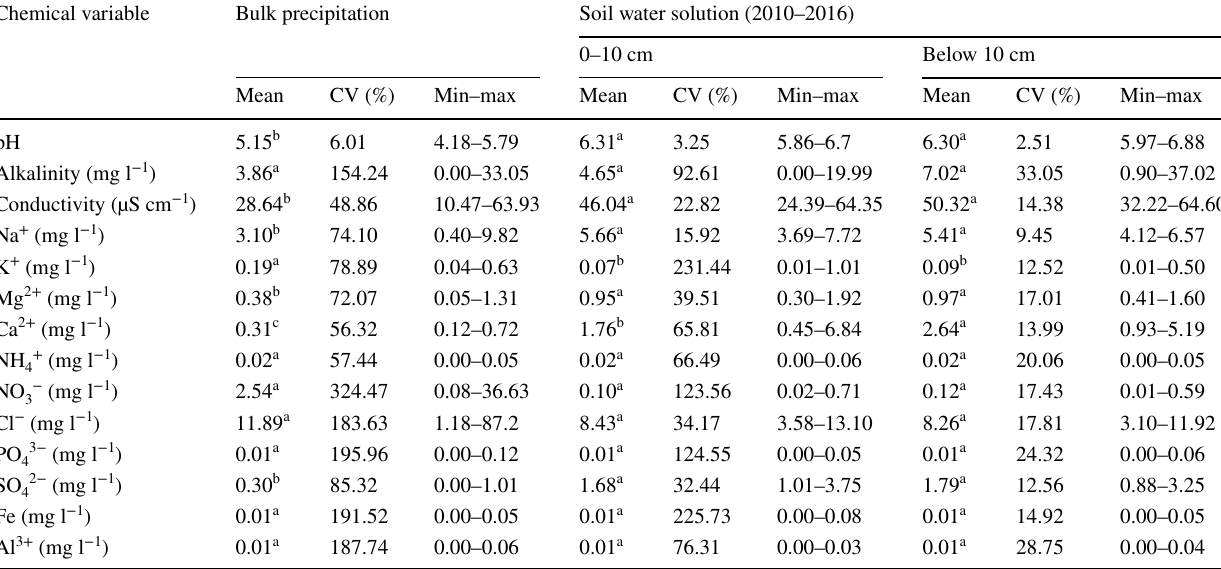
Means with same alphabet (lowercase) are not significantly ( p ≤ 0.05) different from each other but are significantly different from means with different